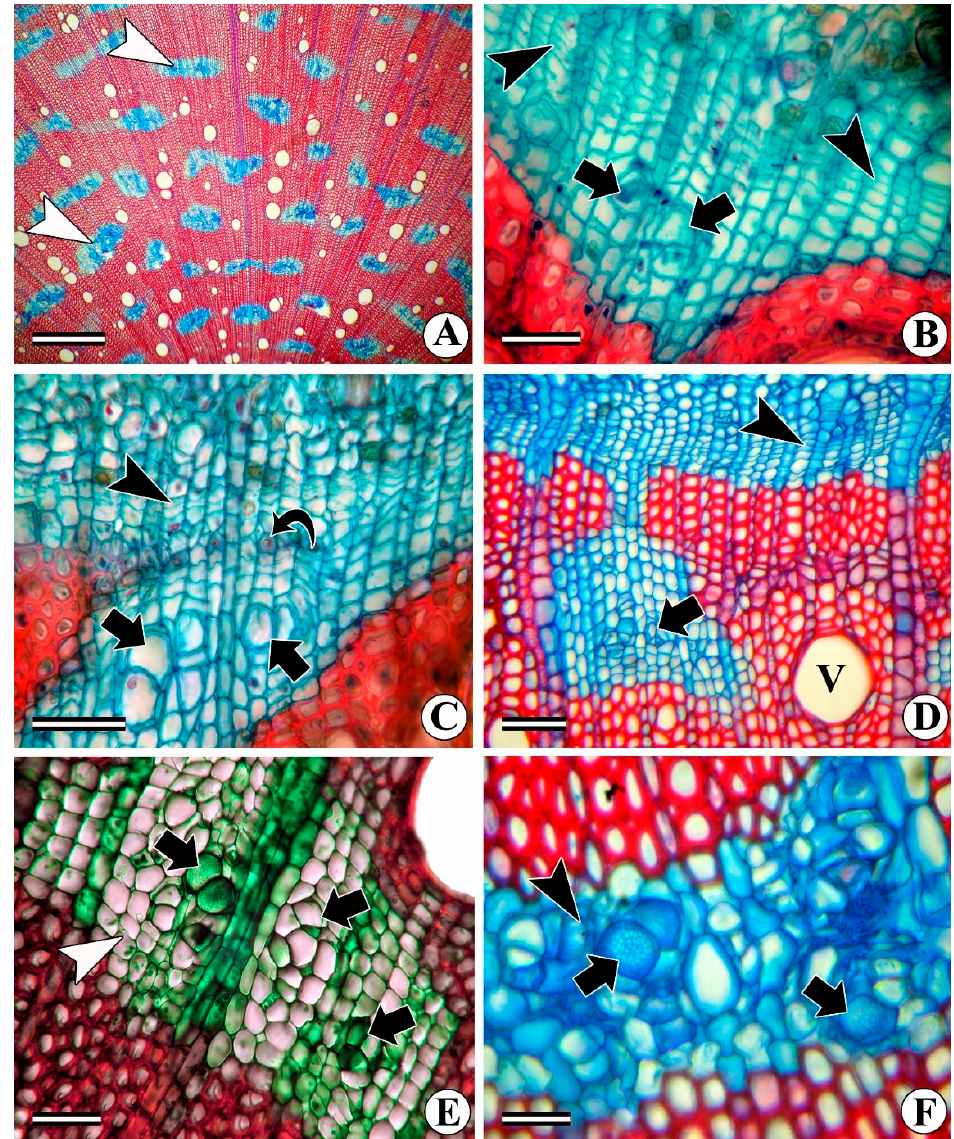
Figure 1. Transverse view of the secondary xylem showing various stages of interxylary phloem development in different species of eudicots. ( A ) Interxylary phloem islands (arrowheads) in the stem of Leptadenia pyrotechnica . ( B ) Differentiating sieve elements from the daughter cells (arrows) of the cambium (arrowheads) in the stem of Mucuna pruriens . ( C ) Differentiation of lignified elements (curved arrow) after a short period of phloem development in the stem of M. pruriens . Note the cambium (arrowhead) and centripetally developed sieve elements (arrows). ( D ) Interxylary phloem (arrow) embedded within the secondary xylem of L. pyrotechnica stem. Arrowhead indicates vascular cambium. Abbreviation : V = vessel ( E , F ) Relatively enlarged view of the sieve tube elements (arrows) enclosed within the xylem of L. reticulata ( E ) and L. pyrotechnica ( F ). Arrowheads indicate phloem-associated parenchyma. Scale bars: A = 500 µm; B, C = 100 µm; D = 200 µm; E = 75 µm; F = 50 µm.